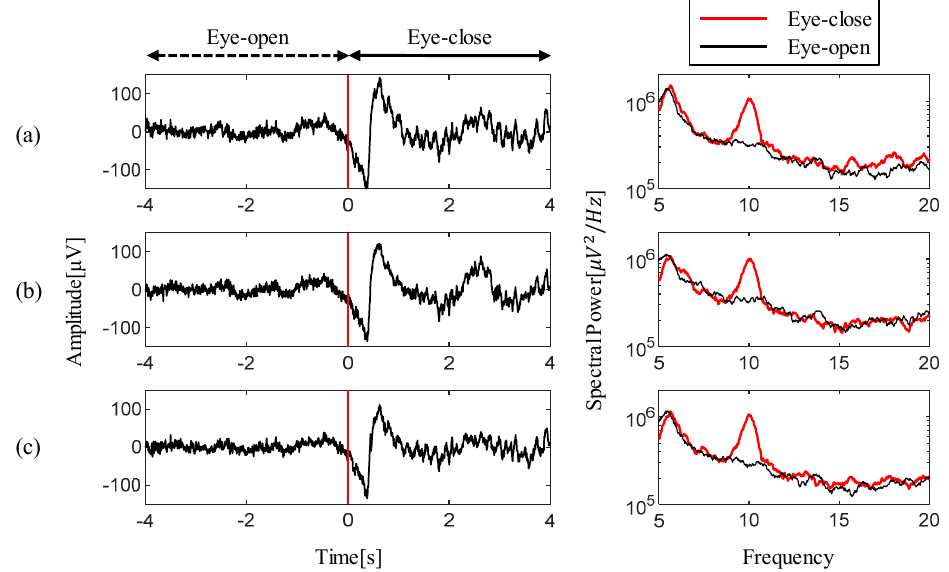
Figure 5. EEG measurements and their spectral comparisons for ( a ) proposed 2-wired active dry electrode, ( b ) alternative 3-wired active dry electrode, and ( c ) passive dry electrode. On the left, the red vertical line on the EEGs indicate the task onset timing for the eye-close instructions. During the eye-close session, activated alpha waves are commonly observed in the time-series and spectral visualization results for all types of electrodes.